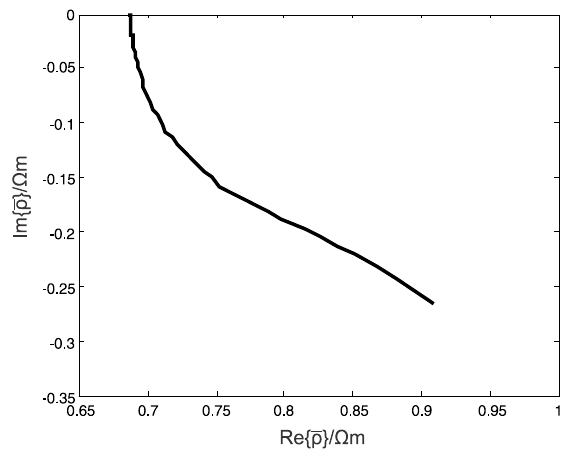
Fig. 5: Measured and extracted suspension impedance (specific complex resistivity) shown in the complex plane. Clearly, in practice the impedance or admittance shapes can quite differ from simple semicircles shown in Figure